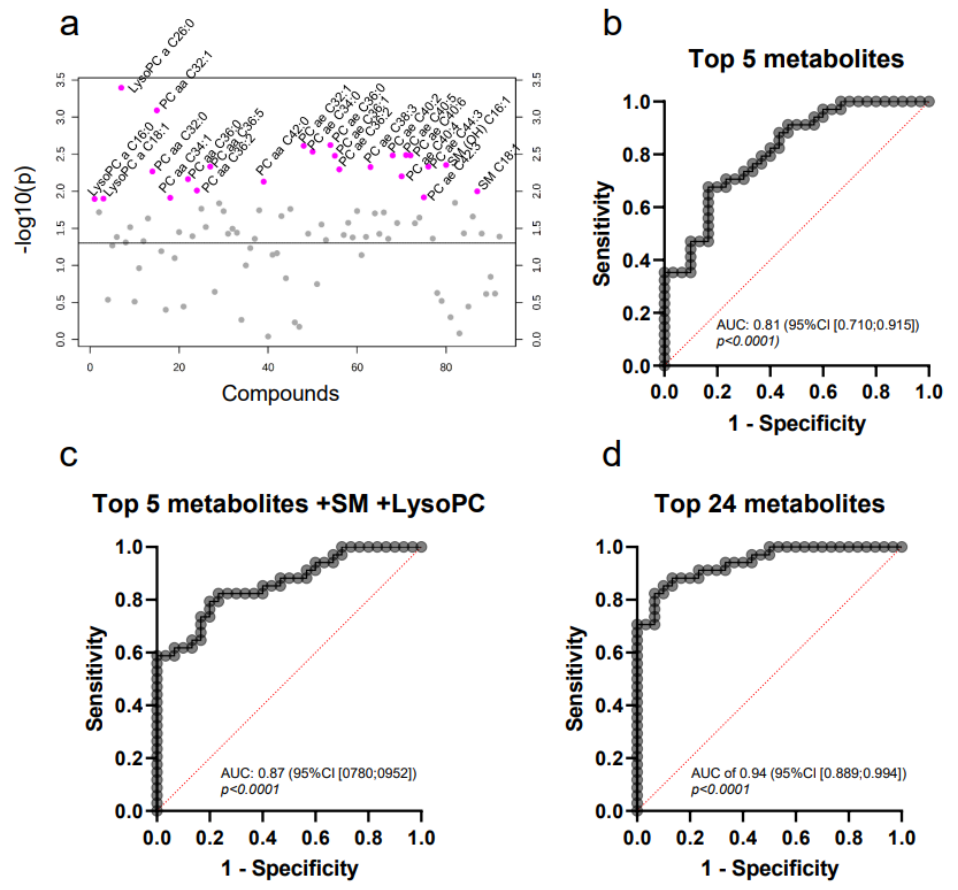
Figure 5. Metabolomic profiling of MV in breast cancer patients of the molecular subtype luminal B compared to healthy controls. T-statistics ( a ) reveal 24 significantly differentially expressed metabo- lites (unpaired Student’s t-test, relevant metabolites colored in pink). Multiple logistic regression ( b ) for the top five metabolites; ( c ) ROC combined for lysophosphatidylcholines, sphingomyelines and PC aa C32:1, PC ae C36:0 and PC ae C34:0; and ( d ) combined ROC of all 24 metabolites.